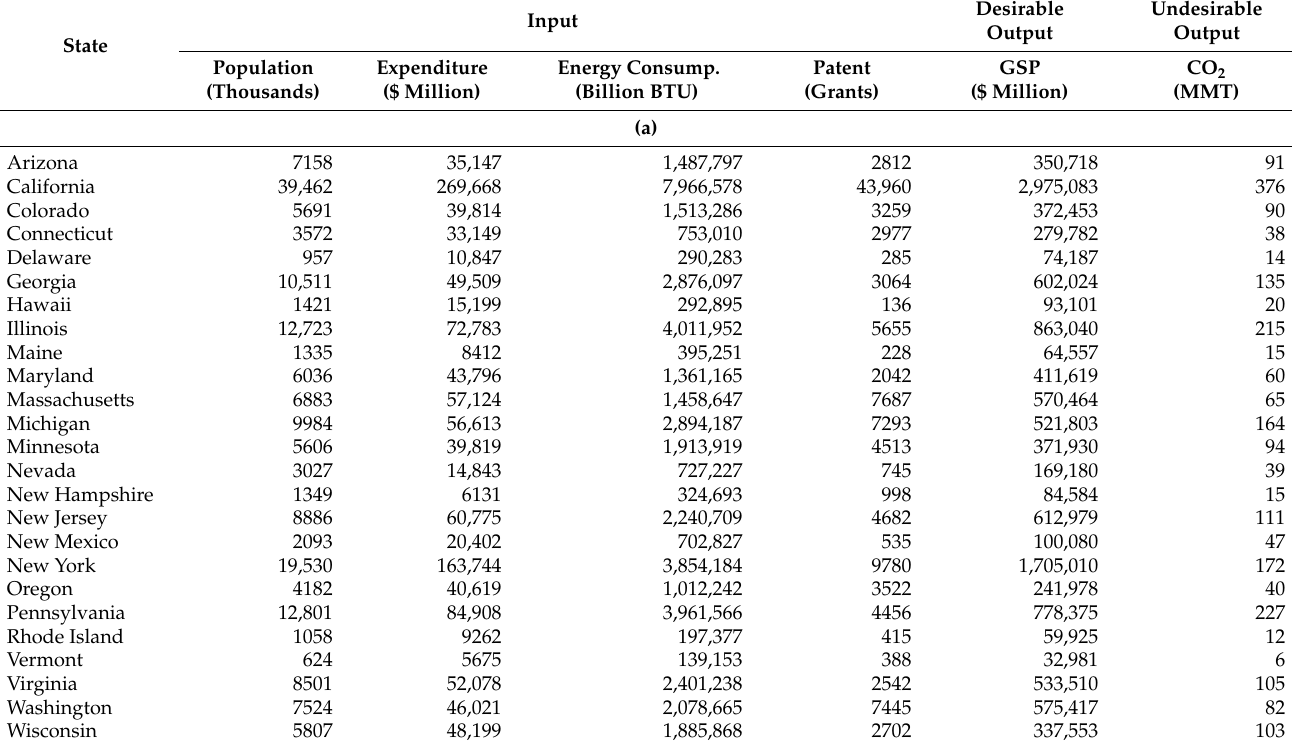
Table 4. Production Factors Data of (a) 25 Blue States and (b) 25 Red States in 2018.